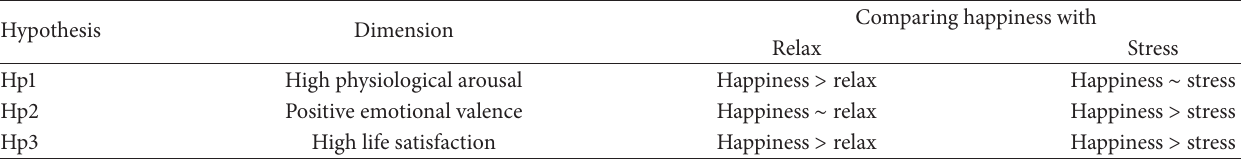
Table 1: Our pseudohypotheses ( ∼ is for similar, > is for greater than, and < is for lower